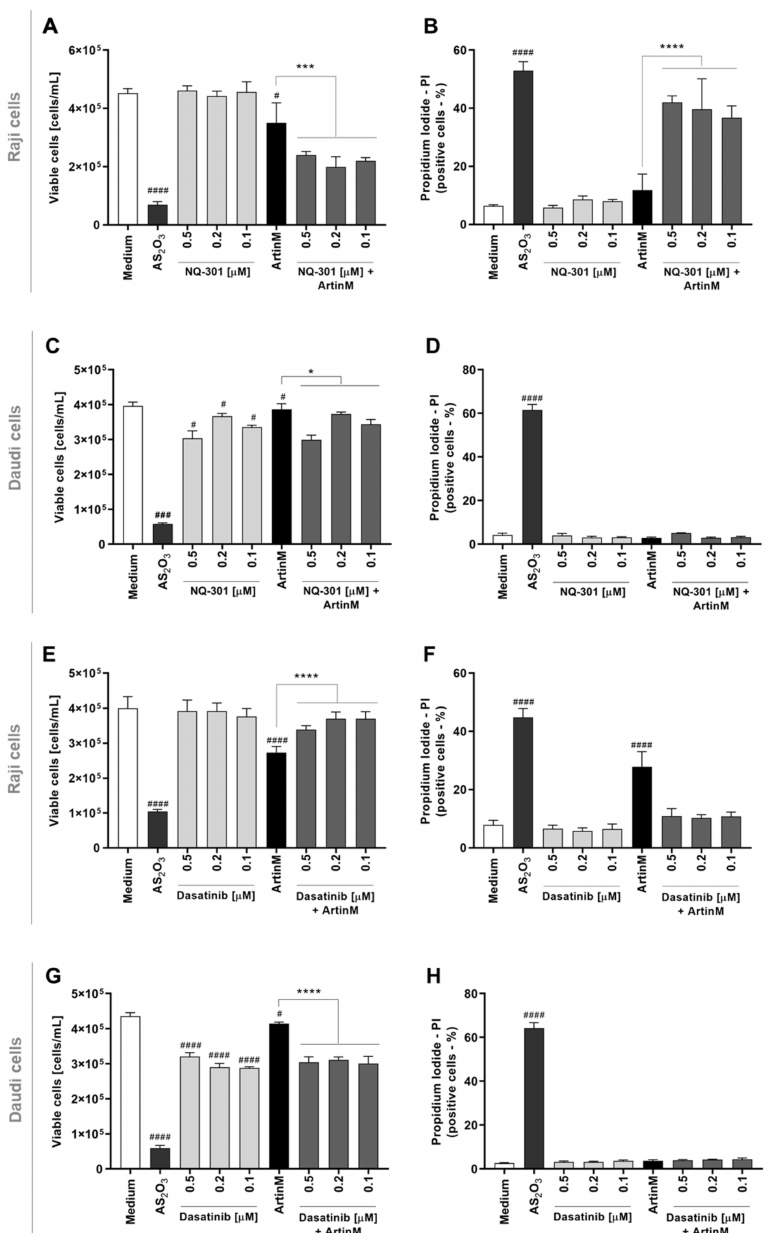
Figure 8. Pharmacological inhibitors of CD45 phosphatase activity and protein tyrosine